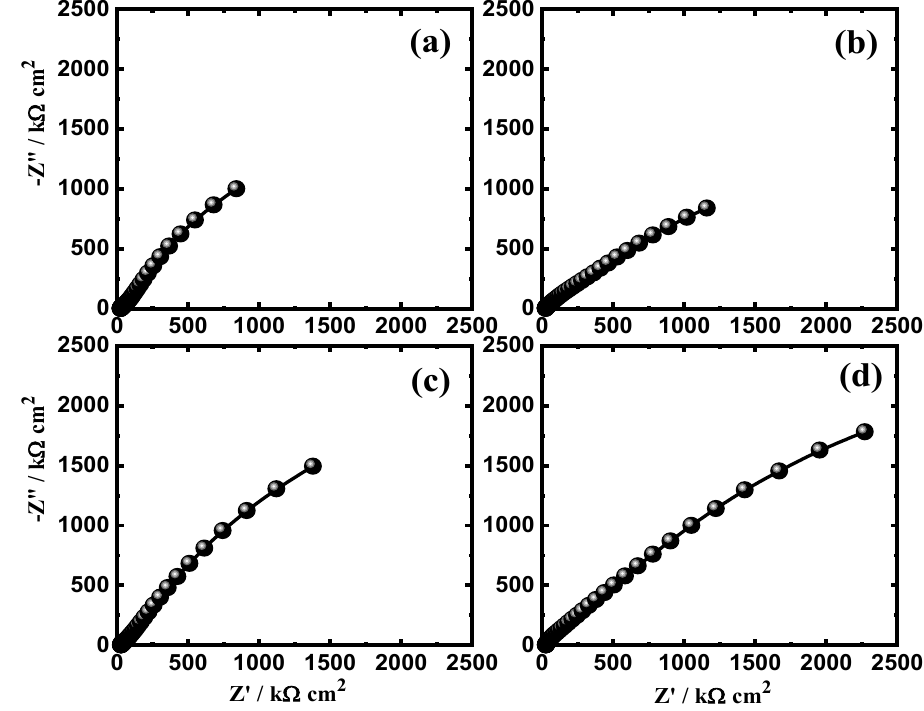
Figure 11. Nyquist plots obtained for iron rod samples after 48 h immersion in ( a ) 3.5% NaCl solutions in the absence and presence of ( b ) 5 × 10 −5 M HAO, ( c ) 1 × 10 −4 M HAO, and ( d ) 5 × 10 −4 M HAO.